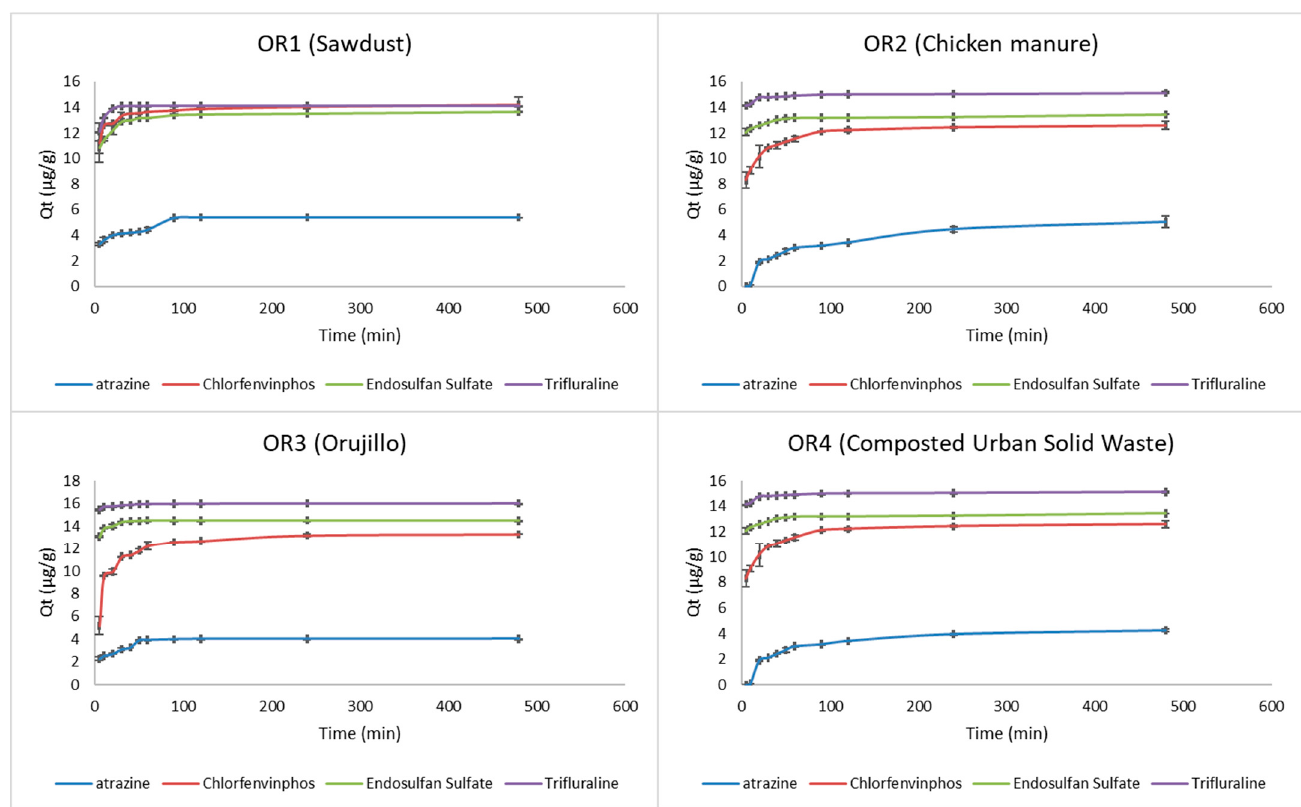
Figure 2. Amount of sorbed pesticides at several times on the four studied organic wastes (OR1— sawdust, OR2—chicken manure, OR3—olive oil solid waste orujillo and OR4—composted urban solid waste).